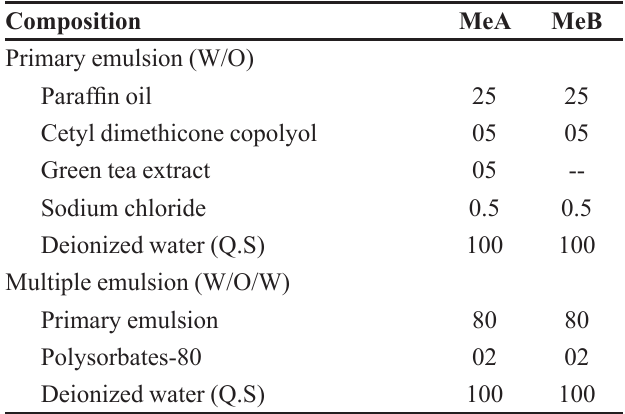
TABLE I - Composition of multiple emulsions (% w/w)